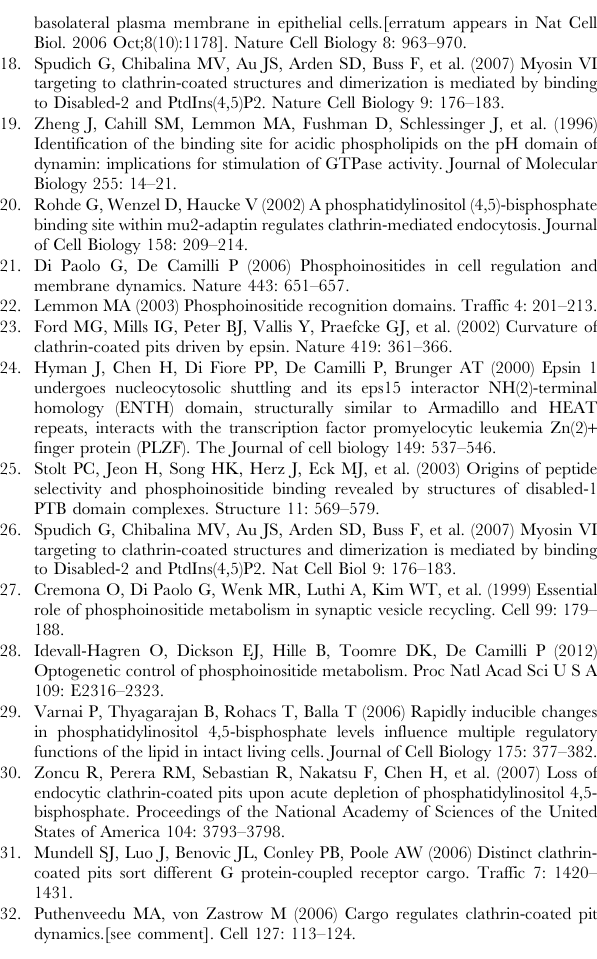
Figure S2 ENTH and PTB domain binding to PtdIns(4,5)P 2 -containing and control liposomes. Increas- ing concentrations of (A) ENTH-GST or (B) PTB-GST were incubated with control or PtdIns(4,5)P 2 -containing liposomes at room temperature for 30 min. The liposomes were pelleted and aliquots of the supernatant and pellet (2.6% and 20% of total, respectively) were separated by SDS-PAGE and stained with Coomassie blue. ENTH and PTB both bind to PtdIns(4,5)P 2 containing liposomes in the pellet (P) fraction. ENTH and PTB are